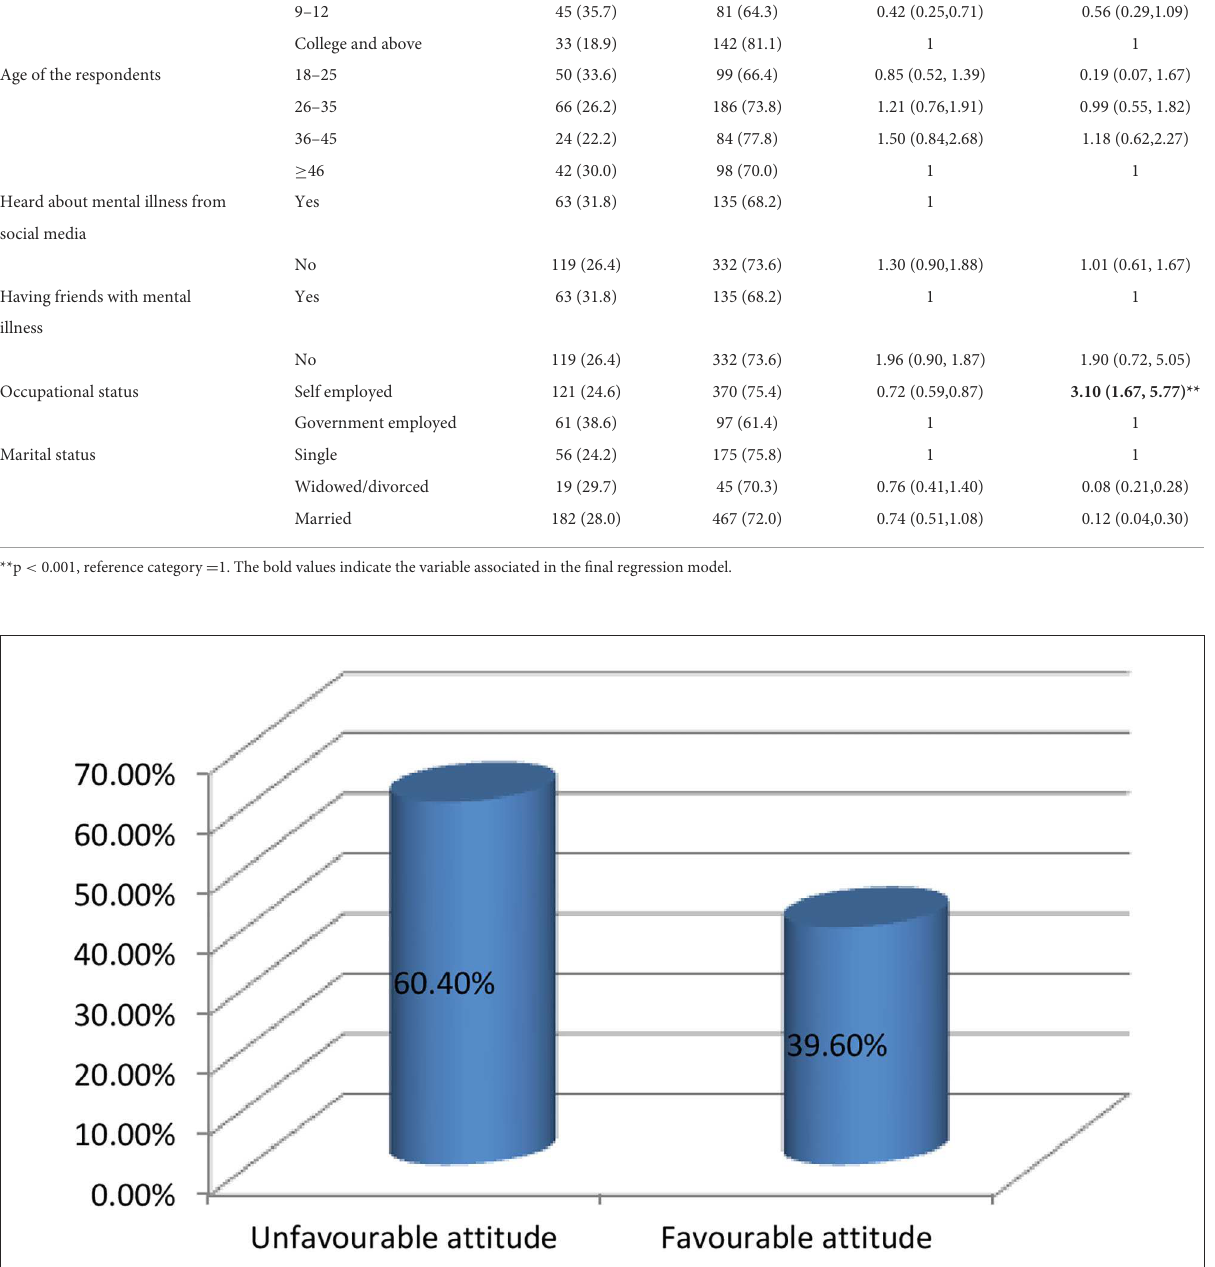
FIGURE3 Attitude of the study respondents toward mental illness among Mattu town residents, South West Ethiopia,